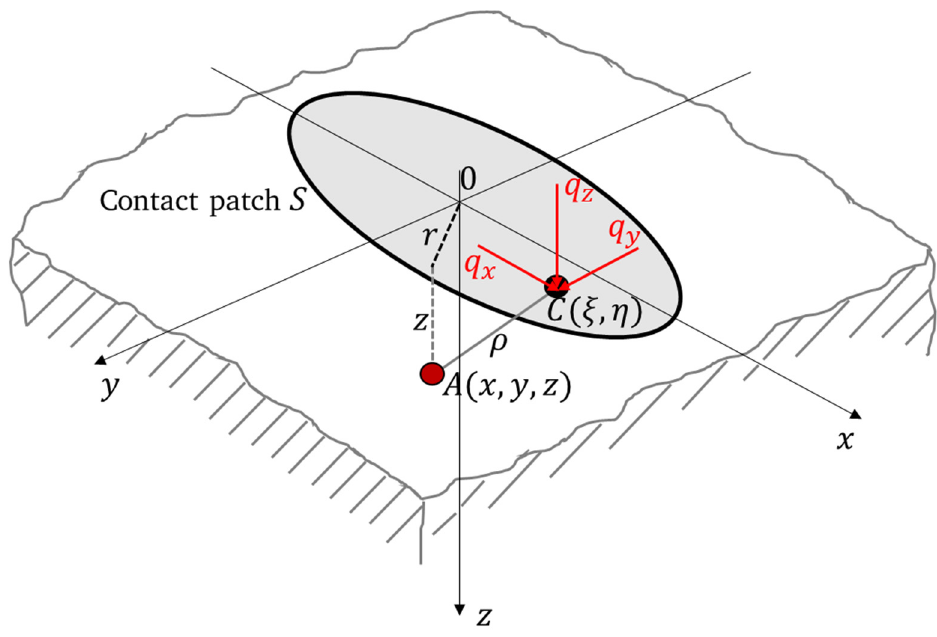
Figure 2. Principles of the subsurface stress calculation, in accordance with [14].